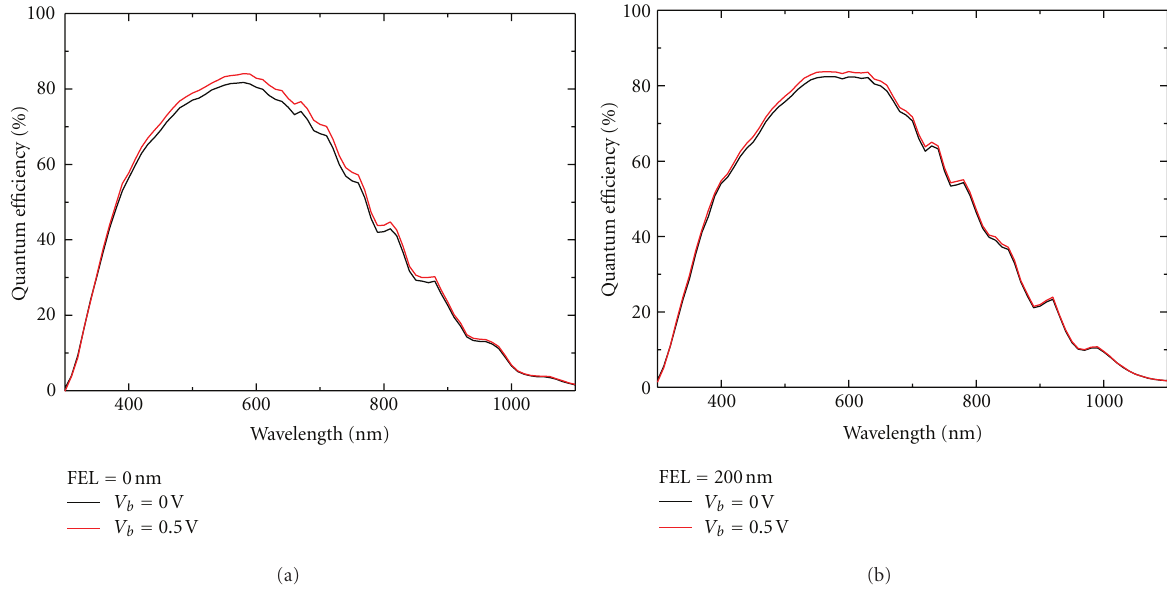
Figure 4: (a) QE spectra of the μ c-Si 0 . 9 Ge 0 . 1 :H solar cell without FEL and (b) with FEL of 200 nm at a reverse bias of 0 and − 0.5 V.